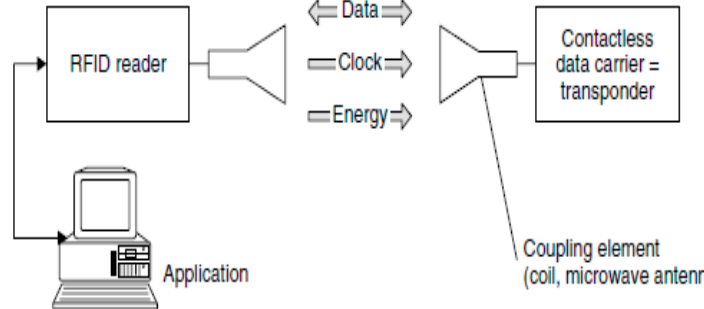
Figure 1. Radio Frequency Identification (RFID) system.